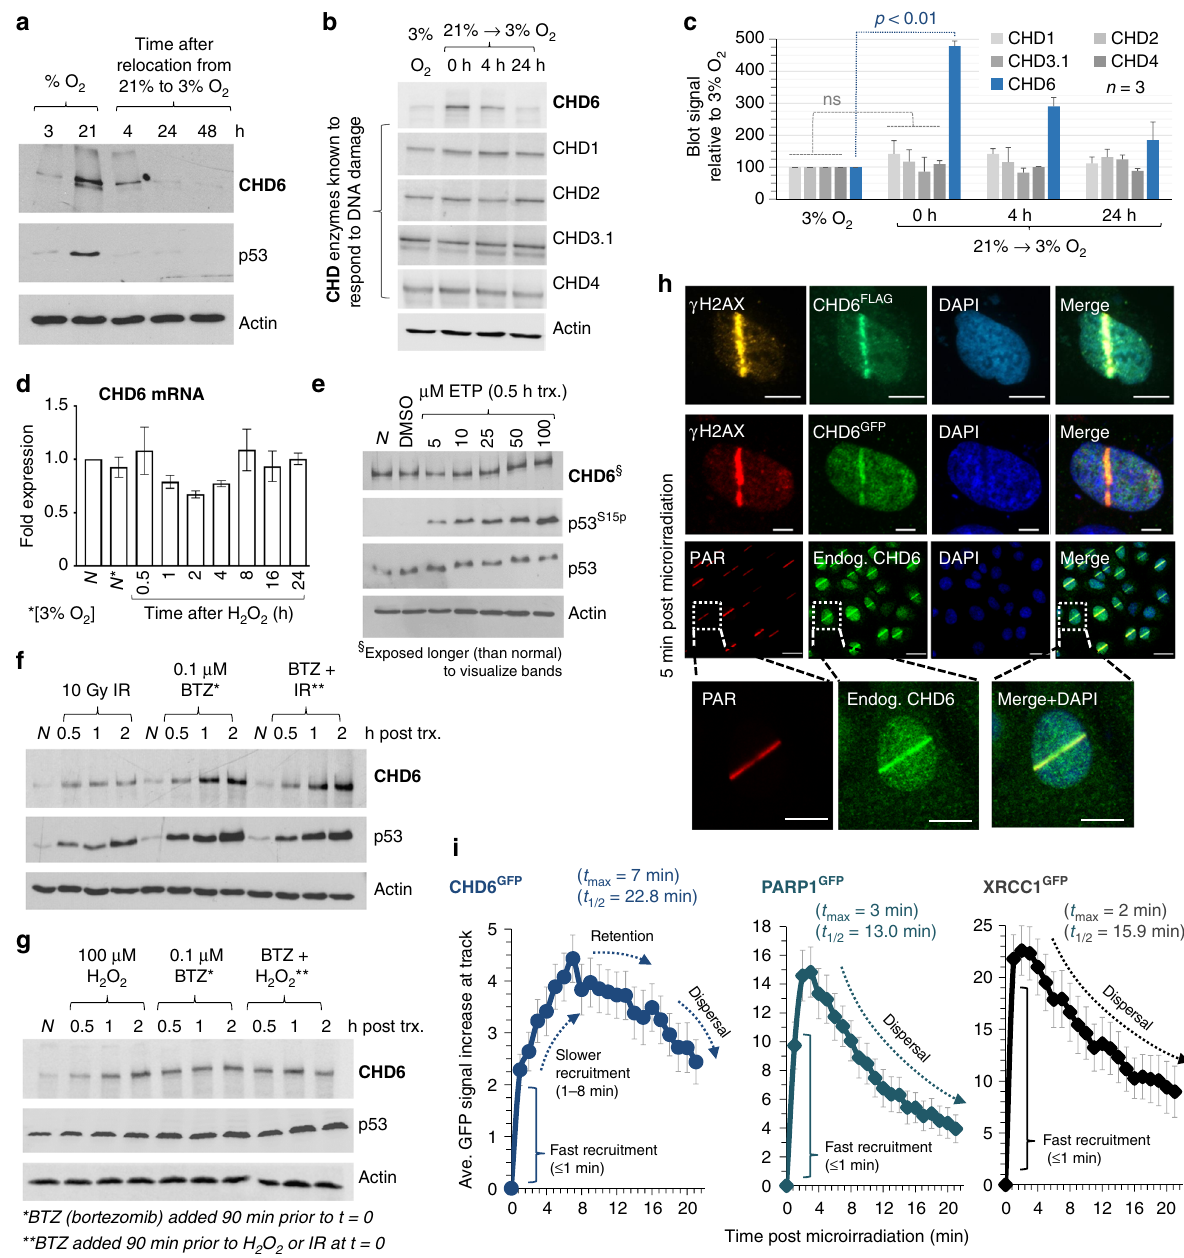
Fig. 1 CHD6 protein levels and localization respond dynamically to oxidative DNA damage. a A549 were cultured at the indicated O 2 levels and immunoblotted for CHD6, p53 and actin. Representative blot shown, n = 3. b Cell extracts from ( a ) were immunoblotted for CHD1, CHD2, CHD3.1, CHD4 or CHD6 and actin. Representative blot shown. c Data from ( b ) was quanti fi ed, error bars = s.d.; n = 3. P values are for Student ’ s t -test. d A549 were exposed ± 500 µ M H 2 O 2 over 24 h, before extraction and analysis by qPCR for CHD6 mRNA, error bars = s.e.m.; n = 3. e A549 were exposed to 5 – 100 µ M etoposide (ETP) for 0.5 h and immunoblotted as in ( a ) with the addition of p53 S15p . Representative blot shown, n = 3. f , g A549 were exposed to H 2 O 2 or 10 Gy ionizing radiation (IR)±bortezomib (BTZ) as indicated and immunoblotted as in ( a ). Representative blots shown, n = 3. h A549 transfected ±CHD6 GFP/FLAG microirradiated, fi xed 5 min later and immunostained for indicated epitopes; scale bars equal 5 µ m. Lower panels show an expanded image of endogenous CHD6 localized at DNA damage tracks; scale bars equal 20 and 5 µ m. i A549 expressing XRCC1 GFP , PARP1 GFP or CHD6 GFP were treated as in ( h ), live imaged over 21 min and quanti fi ed over time as described in Methods. t max = average time to maximum signal. t ½ = average time to 50% loss of maximum signal. Error bars = s.e.m.; n = 30 cells. In all cases, ±refers to with and without damage tracks was not affected by small molecule inhibition of the DSB signaling protein kinases ataxia telangiectasia mutated (ATM) and/or DNA-dependent protein kinase (DNA-PK; Sup- plementary Figs. S1b, c). However, inhibition of PAR polymerase (PARP) activity using Olaparib (PARPi) ablated endogenous CHD6 GFP accumulation (Fig. 3a, b, Supplementary Fig. 1d). NATURE COMMUNICATIONS| (2019) 10:241